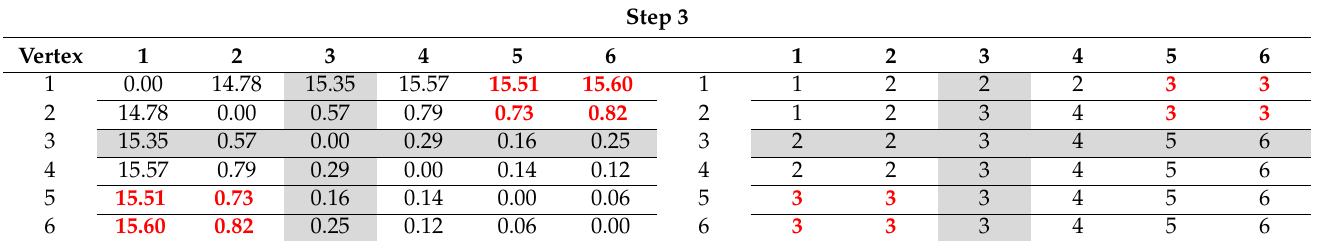
Table A3. The step 3 graphical process of Floyd–Warshall algorithm.